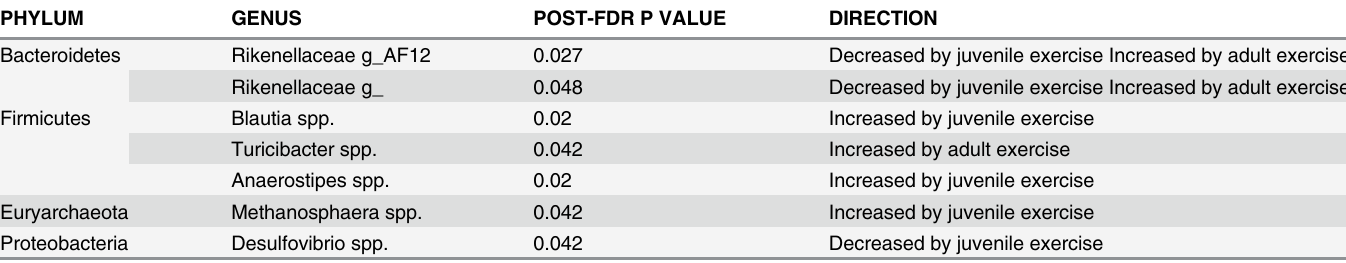
Table 2. Impact of juvenile versus adult onset exercise at the genus